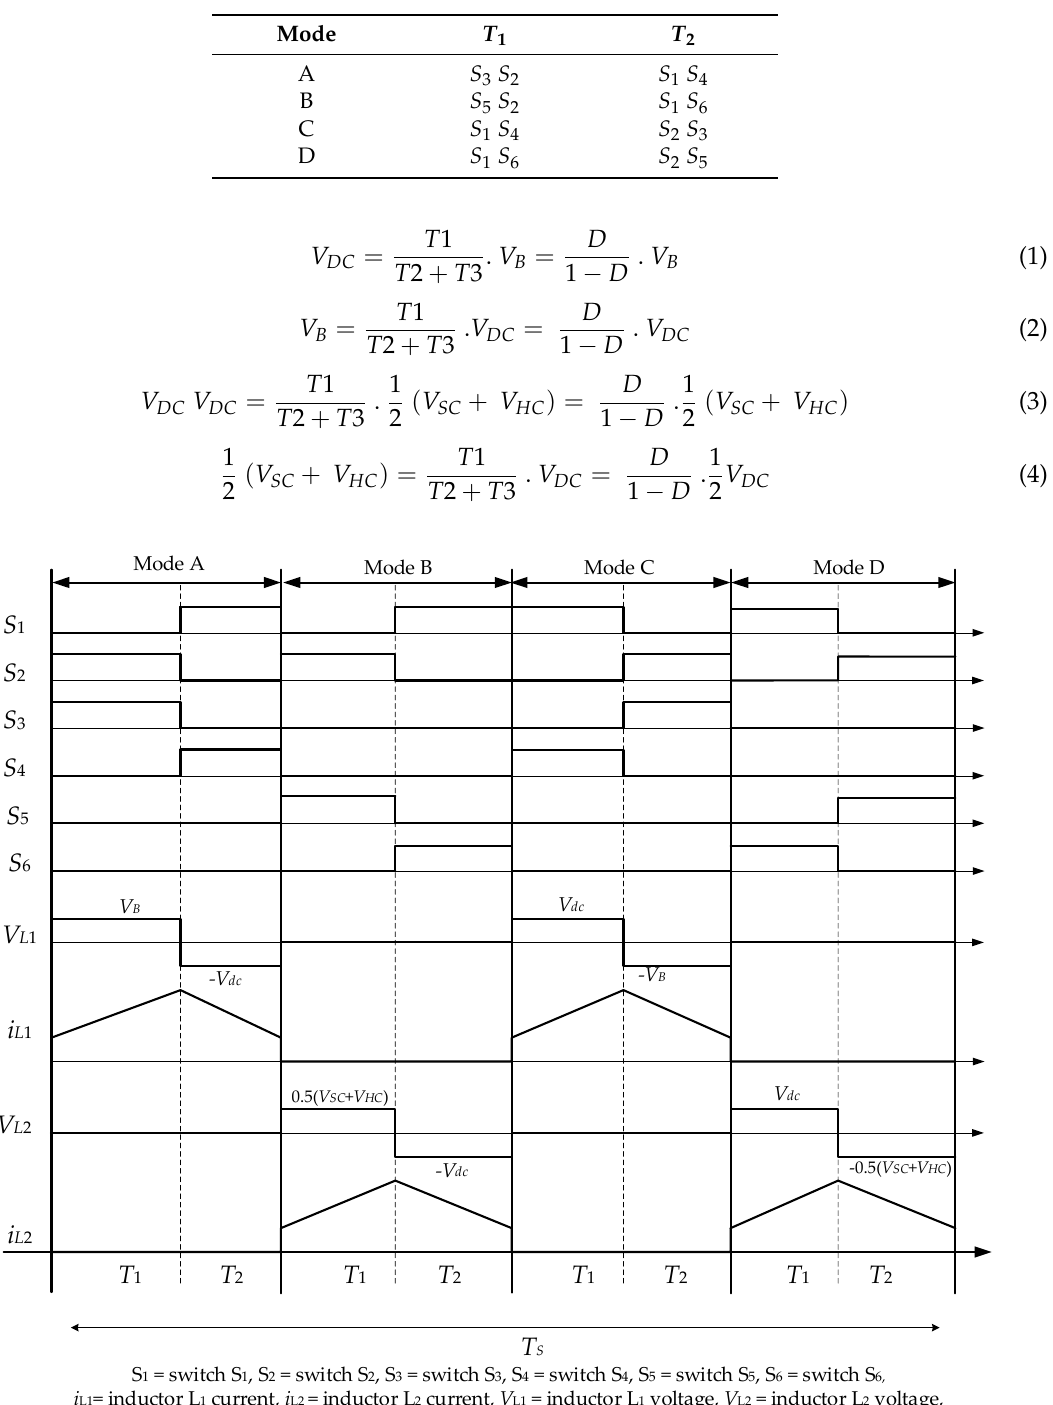
Table 2. Conduction of devices for the operating modes of the multiple input converter.